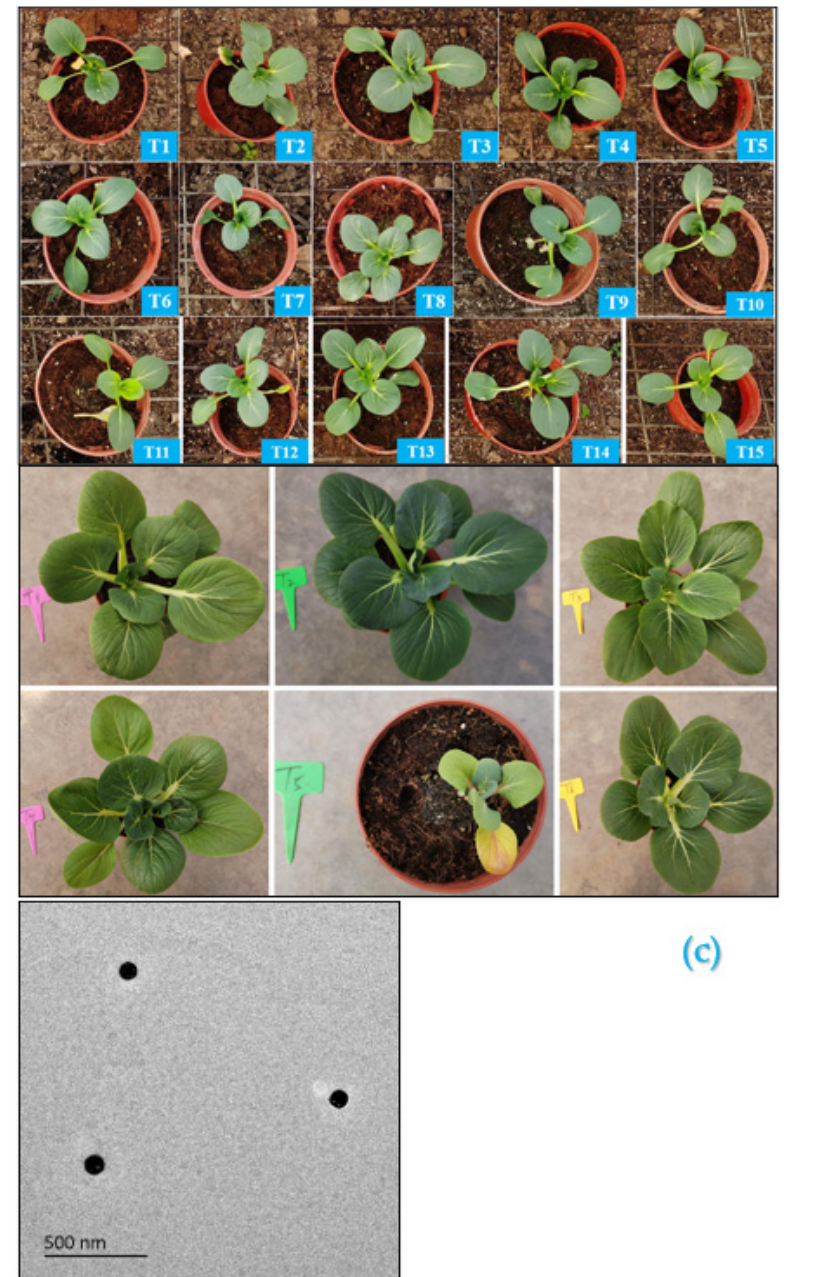
Figure 1. The phenotype of Chinese cabbage in the screening experiment after four weeks ( a ); and the phenotype of Chinese cabbage in the comparison experiment after four weeks ( b ). The BNPs TEM image ( c ). (Note, in Figure a, T1: N-P-K=0-0-0, T2: N-P-K=0-2-2, T3: N-P-K=1-2-2, T4: N-P-K=2-0-2, T5: N-P-K=2-1-2, T6: N-P-K=2-2-2, T7: N-P-K=2-3-2, T8: N-P-K=2-2-3, T9: N-P-K=2-2-0, T10: N-P-K=2-2-1, T11: N-P-K=3-2-2, T12: N-P-K=1-3-2, T13: N-P-K=1-1-2, T14: N-P-K=1-2-1, T15: N-P-K=2-1-1; in Figure 2, T1: BNPs-N-K=1:2:2, T2: BNPs-N-K=2:2:2, T3: BNPs -N-K=2:1:1, T4: BNPs-N-K=2:0.5:0.5, T5: BNPs-N-K=2:0:0, T6: BNPs-N-K=0:2:2; BNPs, biochar nanoparticles; 1 unit means 0.5 g/L nutrient).